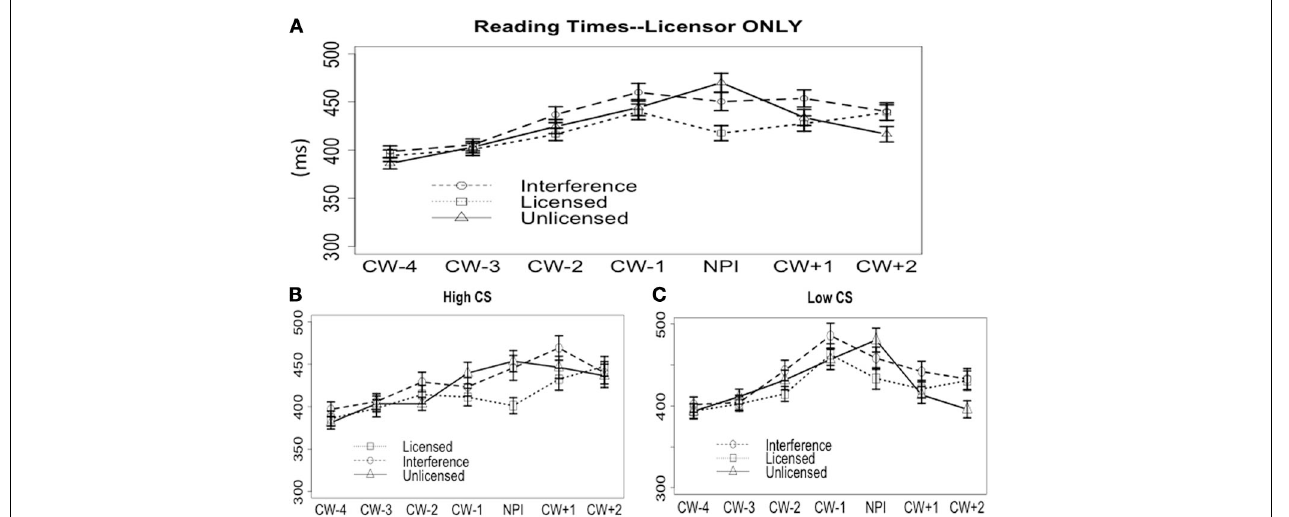
FIGURE 6 | Reading times when the NPI licensor was “ only. ” (A) Word-by-word reading time cross all subjects. (B) Word-by-word reading time for the high CS group. (C) Word-by-word reading time for the low CS group.